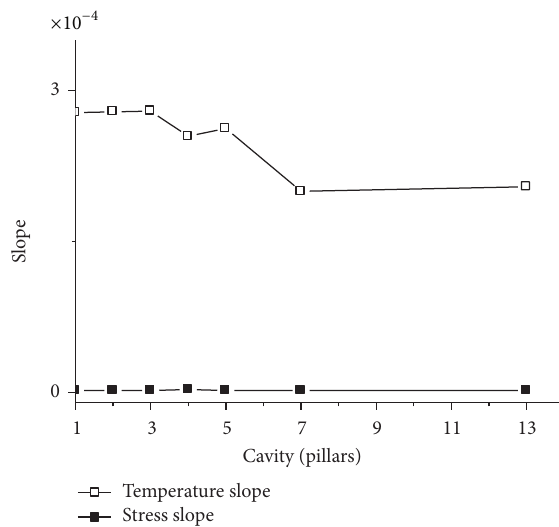
Figure 16: The slope and its error of the linear fitted curves for the resonantfrequency,whichhasthebiggestaveragenormalizedpower spectrum, change with stress on 𝑥 direction.